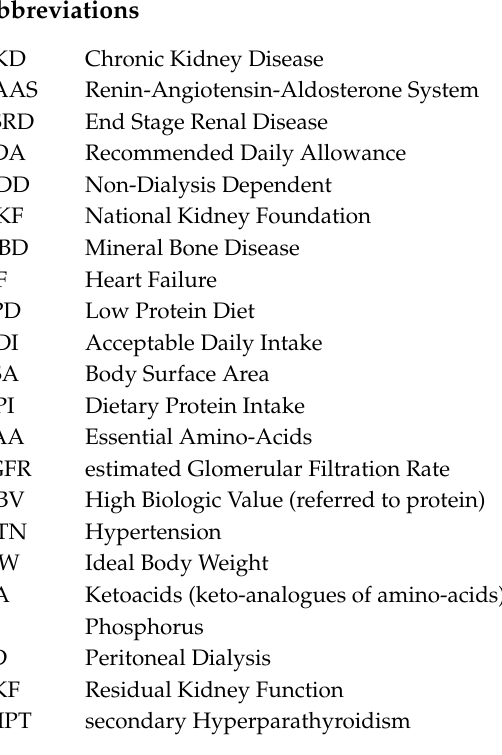
S1: Pragmatic dietary approaches to mild, moderate and severe chronic hyperkalaemia; Figure S2: General advices for dietary management of